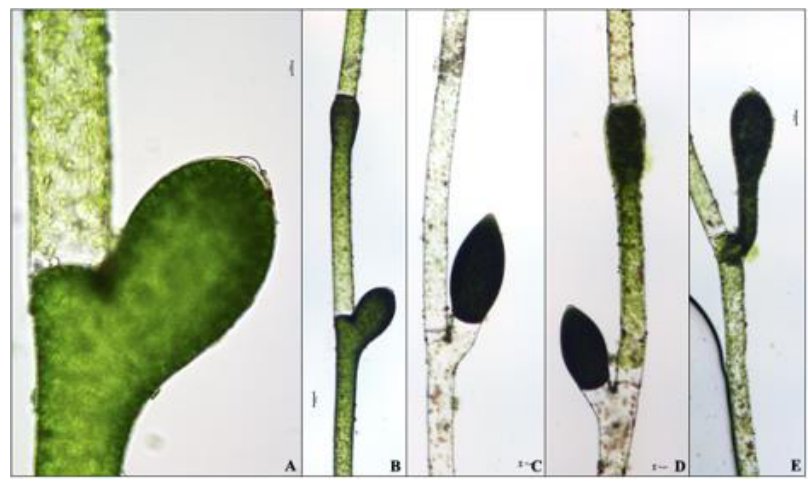
Figure 5. Germination of an intercalary akinete of Pithophora roettleri divided with or without a transversal, parting cell wall. ( A ) 400× magnification. ( B – E ) 100× magnification. ( A – D ) Interrupted germination of a branch process with an akinete forming ( A ) within the same cell with some of the upper end of the akinetes assuming a beak-like process. ( E ) Germinated branch at a 45° angle with the upper end of the branch process transformed into an akinete. Scale bar = 10 µm.